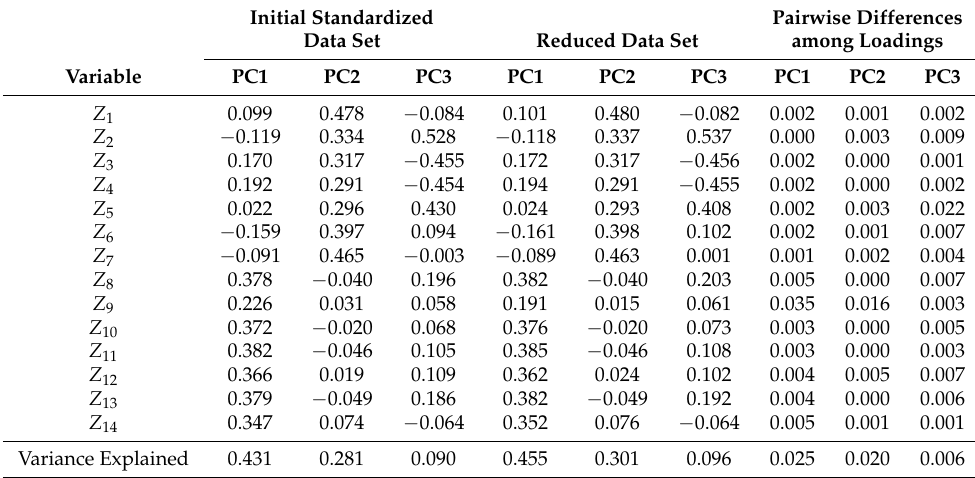
Table 2. PCA loadings for the first three PCs using the initial standardized data set and the reduced data set. The pairwise differences for the two analyses are presented in the last three columns. Initial Standardized Pairwise Differences Data Set Reduced Data Set among